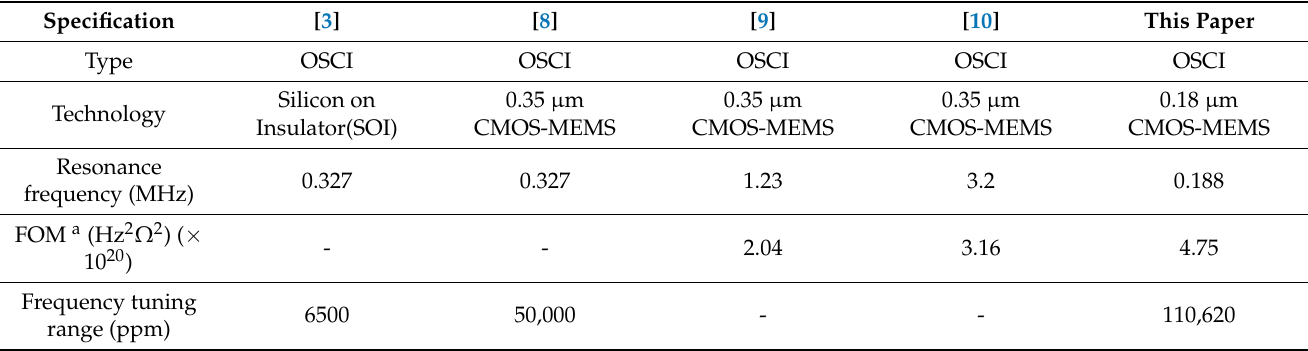
a FOM: Figure of